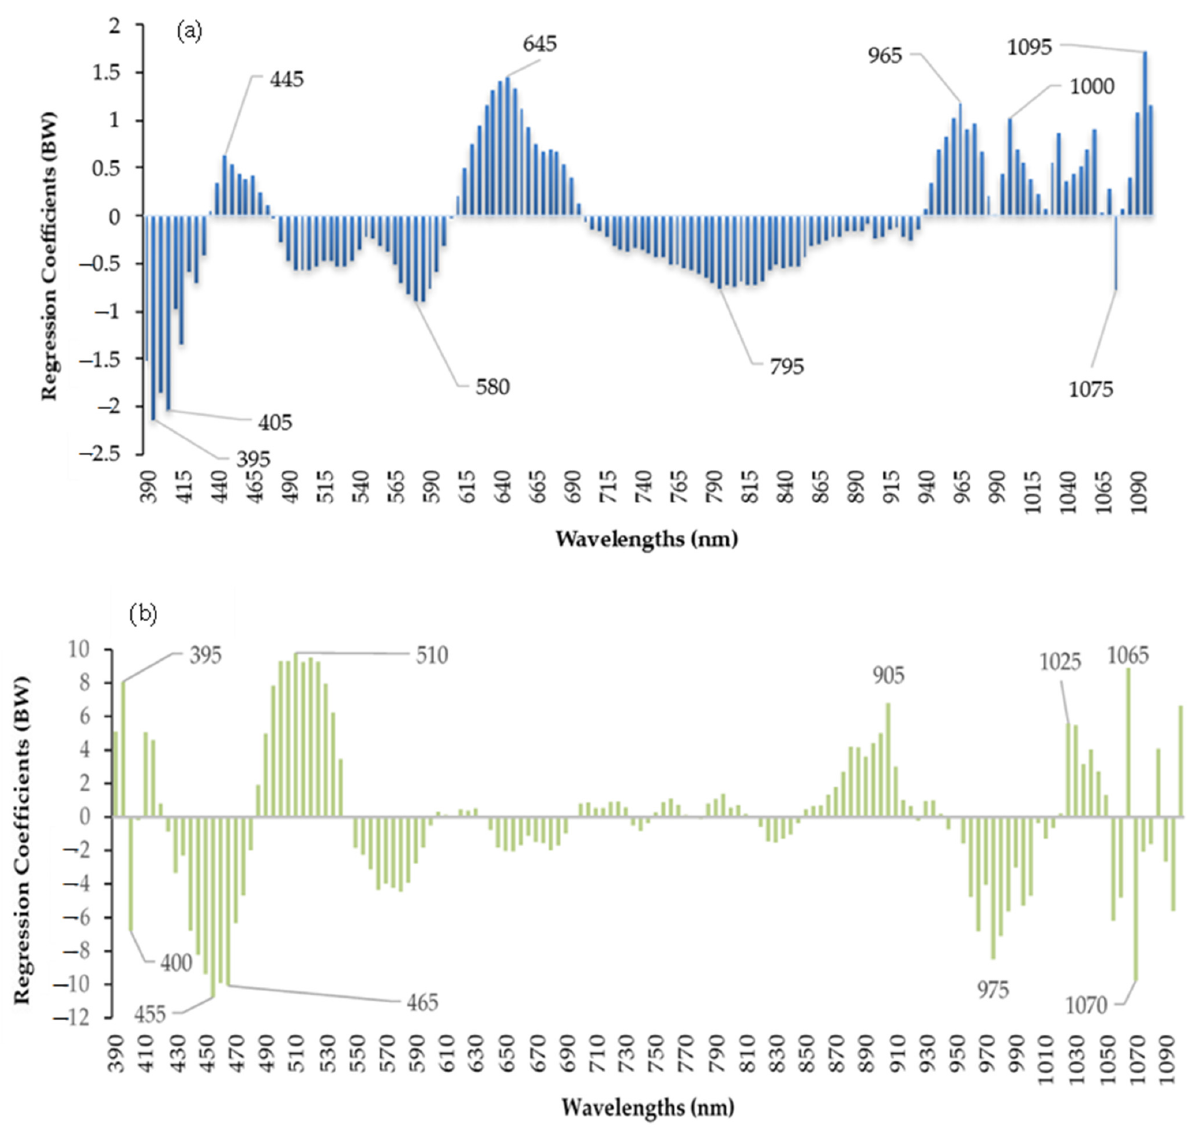
Figure 3. Selection of the important wavelengths for gumminess ( a ) and adhesion ( b ) from the PLSR model. Table 6. Calibration and validation statistics for predicting textural attributes of sausage core using PLSR with selected important wavelengths